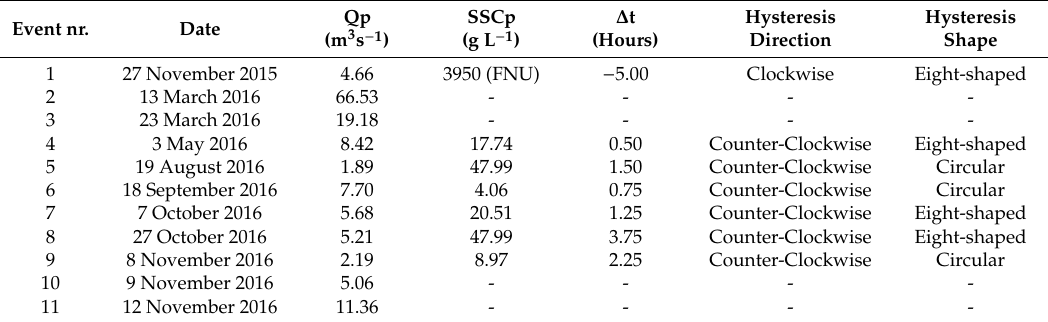
Table 2. Characteristics of the events occurred during the monitoring period. Qp is the peak flow; SSCp is the peak SSC, ∆ t is the time lag between Qp and SSCp. Event